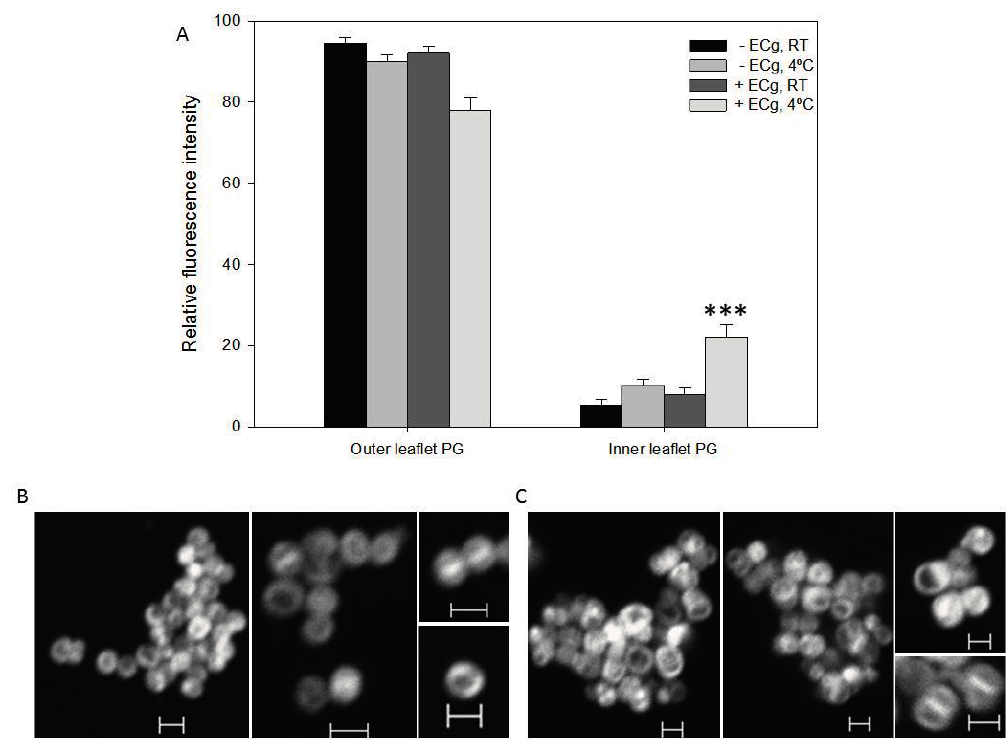
Figure 3. ECg elicits small but significant changes to the distribution of PG across the EMRSA-16 CM. ( A ) relative fluorescence intensity (±1 SD) of 18:1–06:0 NBD-PG labelled cells grown in the absence or presence of 12.5 µg/mL ECg. Fluorescence emission was measured after 30 min exposure to the lipid analogue and following quenching with 25 mM sodium dithionate at room RT and 4 °C ( n = 5). *** p < 0.001; two-tailed Student’s t . Fluorescence determined by flow cytometry (10,000 events collected). CLSM of EMRSA-16 grown in the absence ( B ) and presence ( C ) of 12.5 µg/mL ECg; cells were labeled with 10 µM 18:1–06:0 NBD-PG at RT. Scale bars 1